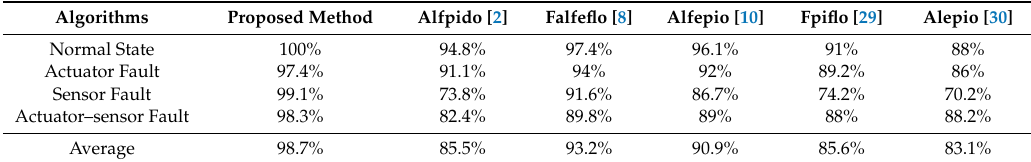
Figure 4. Torque and position residual signals of robot manipulator’s joints in normal and abnormal conditions based on the neural high-order variable structure observer (NHVSO) algorithm. Table 4. Fault diagnosis results for the robot manipulator based on various state-of-art techniques.